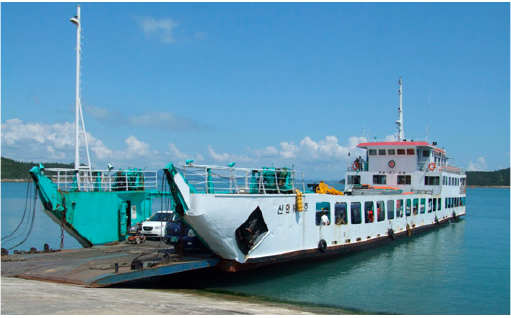
Figure 7. Photograph of the target vessel Shinan Ferry No. 5 (http://sanews.co.kr/2817, accessed on 1 May 2022).